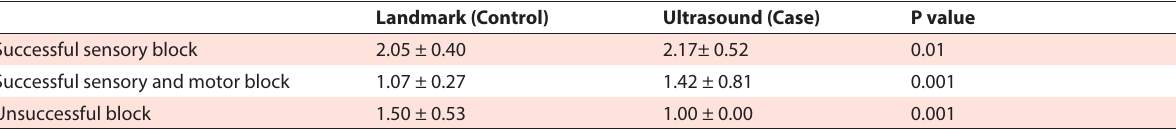
Table 2. Comparison of nerve blocking success between the patients undergoing landmark-based and ultrasound-guided methods 30 minutes post-intervention Landmark